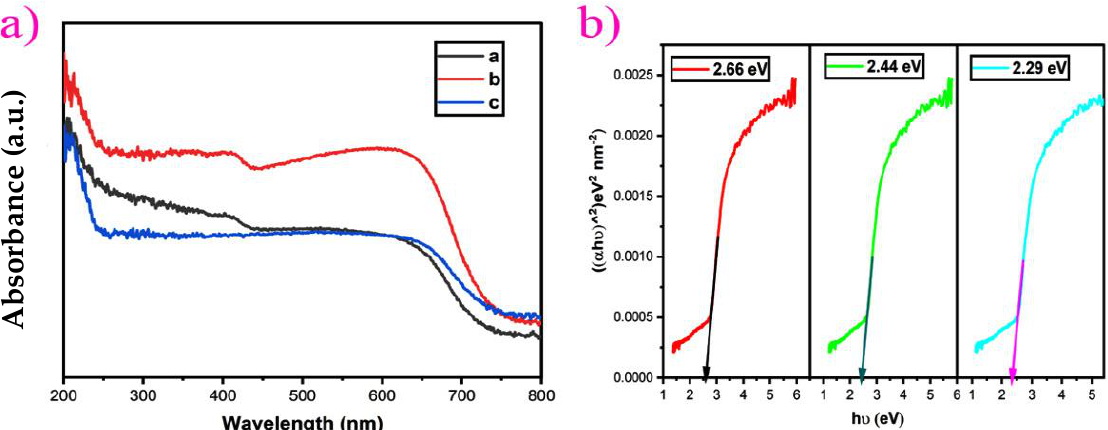
Figure 4. ( a ) UV–Vis DRS spectra and ( b ) bandgap spectrum of the Sr [0.01 (a), 0.05 (b) and 0.1 (c)] doped ZnSe